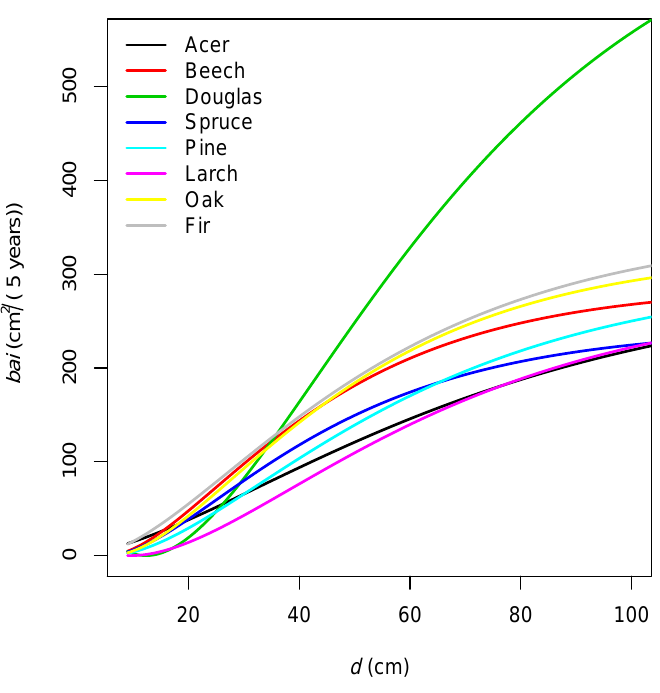
Figure 4. Expected mean growth for tree